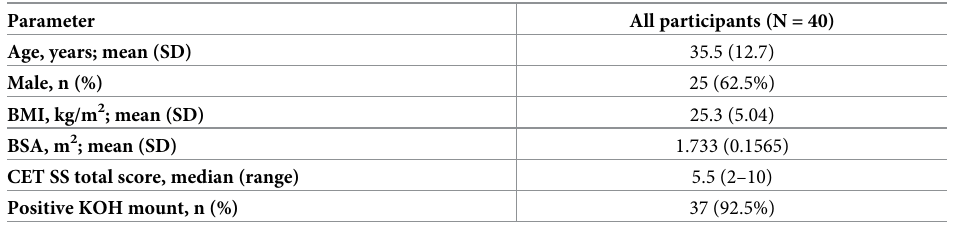
Table 1. Baseline and disease characteristics of participants.